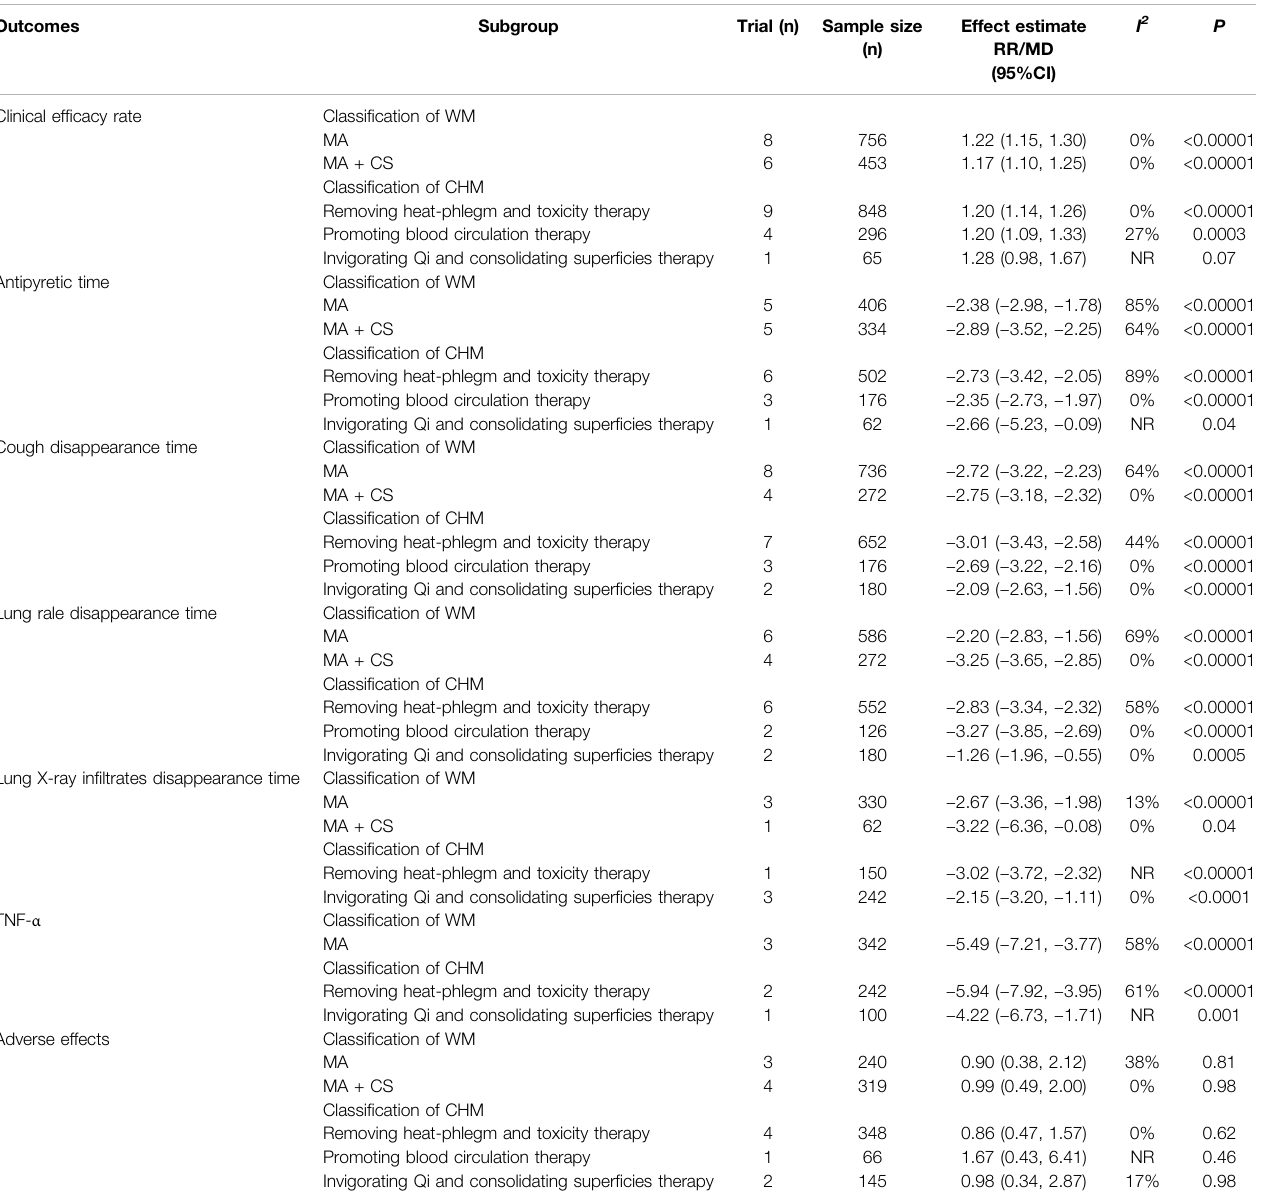
TABLE 2 | Summarized results of subgroup analyses. Outcomes Subgroup Trial (n) Sample size